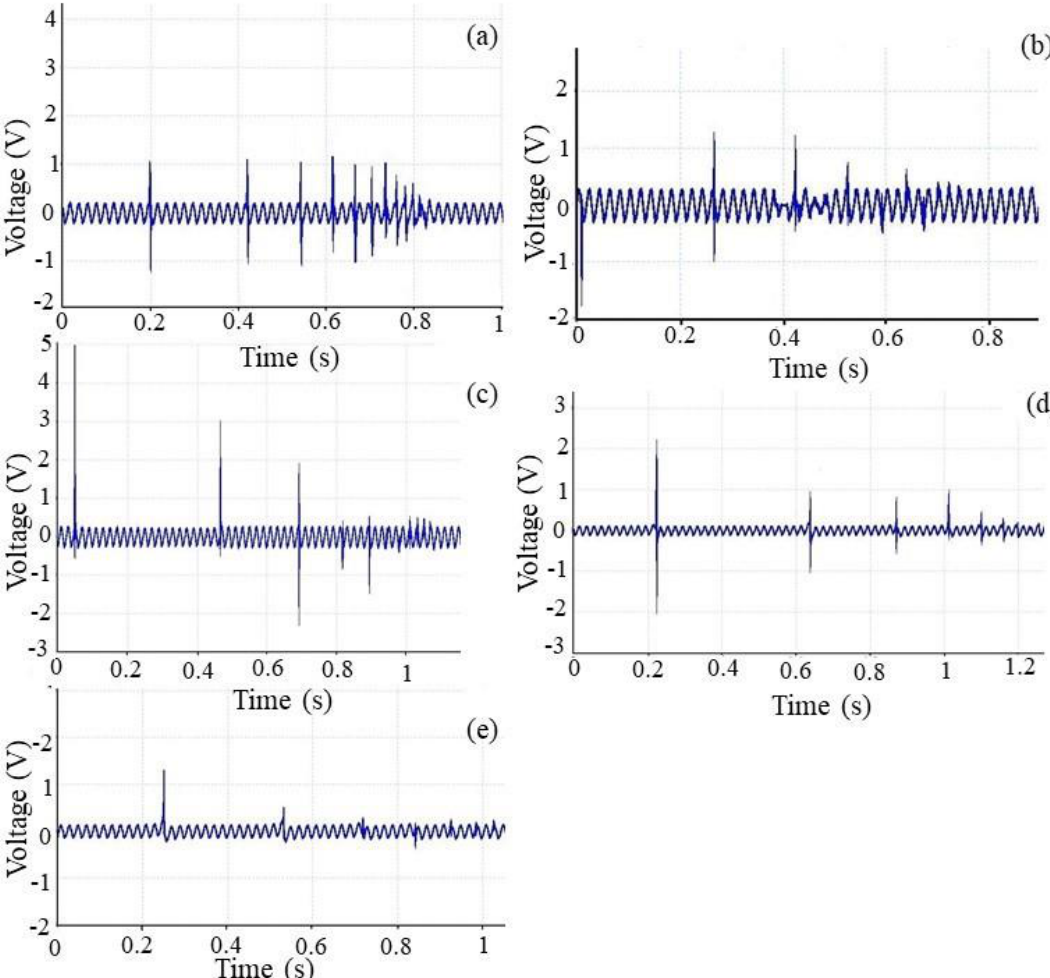
Figure 8. Representative piezoelectric response of PVDF/LiCl nanogenerators. Excitation device obtained from a ball falling down for different web thicknesses: ( a )150 μm, ( b ) 250 μm, ( c ) 350 μm, ( d ) 450 μm, and ( e ) 550 μm.